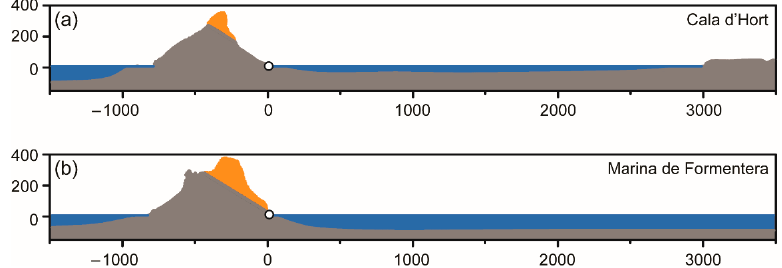
Figure 2. Central sections of the slide profiles marked in light brown for ( a ) scenario 1 and ( b ) scenario